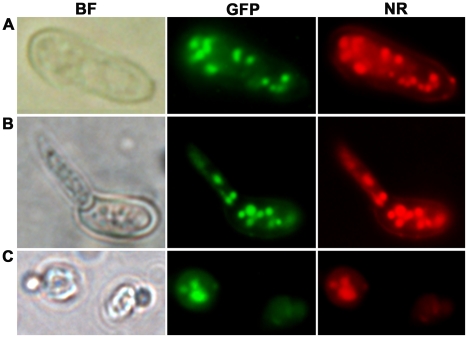
Intracellular localization of MEST1 in Metarhizium robertsii Mr2575 and budding yeast Saccharomyces cerevisiae.Co-localization of MEST1 and neutral lipids demonstrated by Nile red staining of GFP-MEST1 expressing cells in (A) an ungerminated M. anisopliae conidium, (B) a germinated M. anisopliae conidium and (C) a budding yeast (S. cerevisiae) cell. BF, bright field microscopy. GFP, fluorescence filter. NR, Nile red staining.